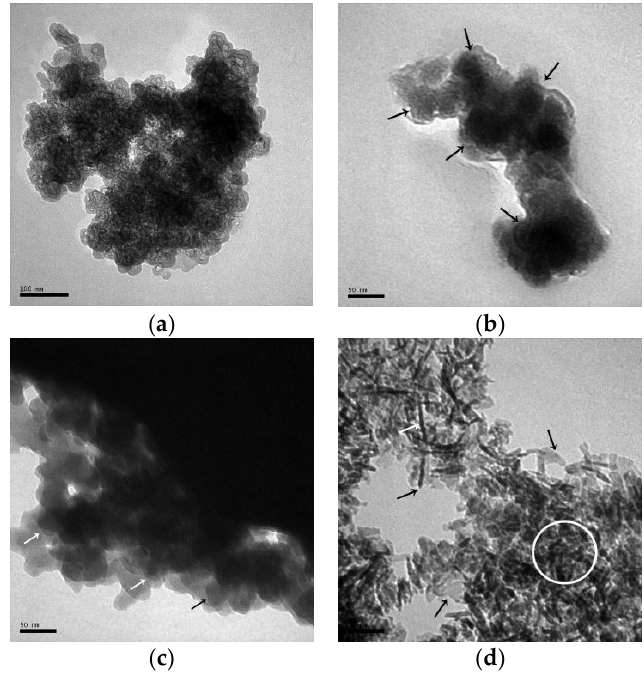
Figure 12. TEM images of the N-A-S-H system products. ( a ) NASH1.0_R_7d; ( b ) NASH1.0_60_7d; ( c ) NASH2.0_60_7d; ( d ) NASH1.0_95_7d.